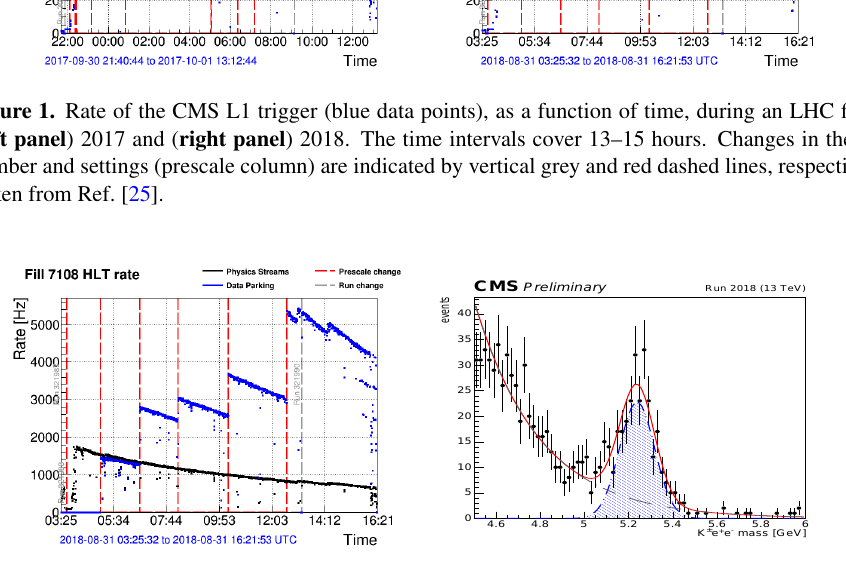
Figure 2. Left panel: the trigger rates of the CMS HLT system as a function of time during an LHC fill in 2018, for the physics (black data points) and B parking (blue data points) streams. Right panel: Invariant mass distribution for candidate B + → K + (J / Ψ → )e + e − decays, obtained from a small fraction of the B parking data sample. Taken from Ref.